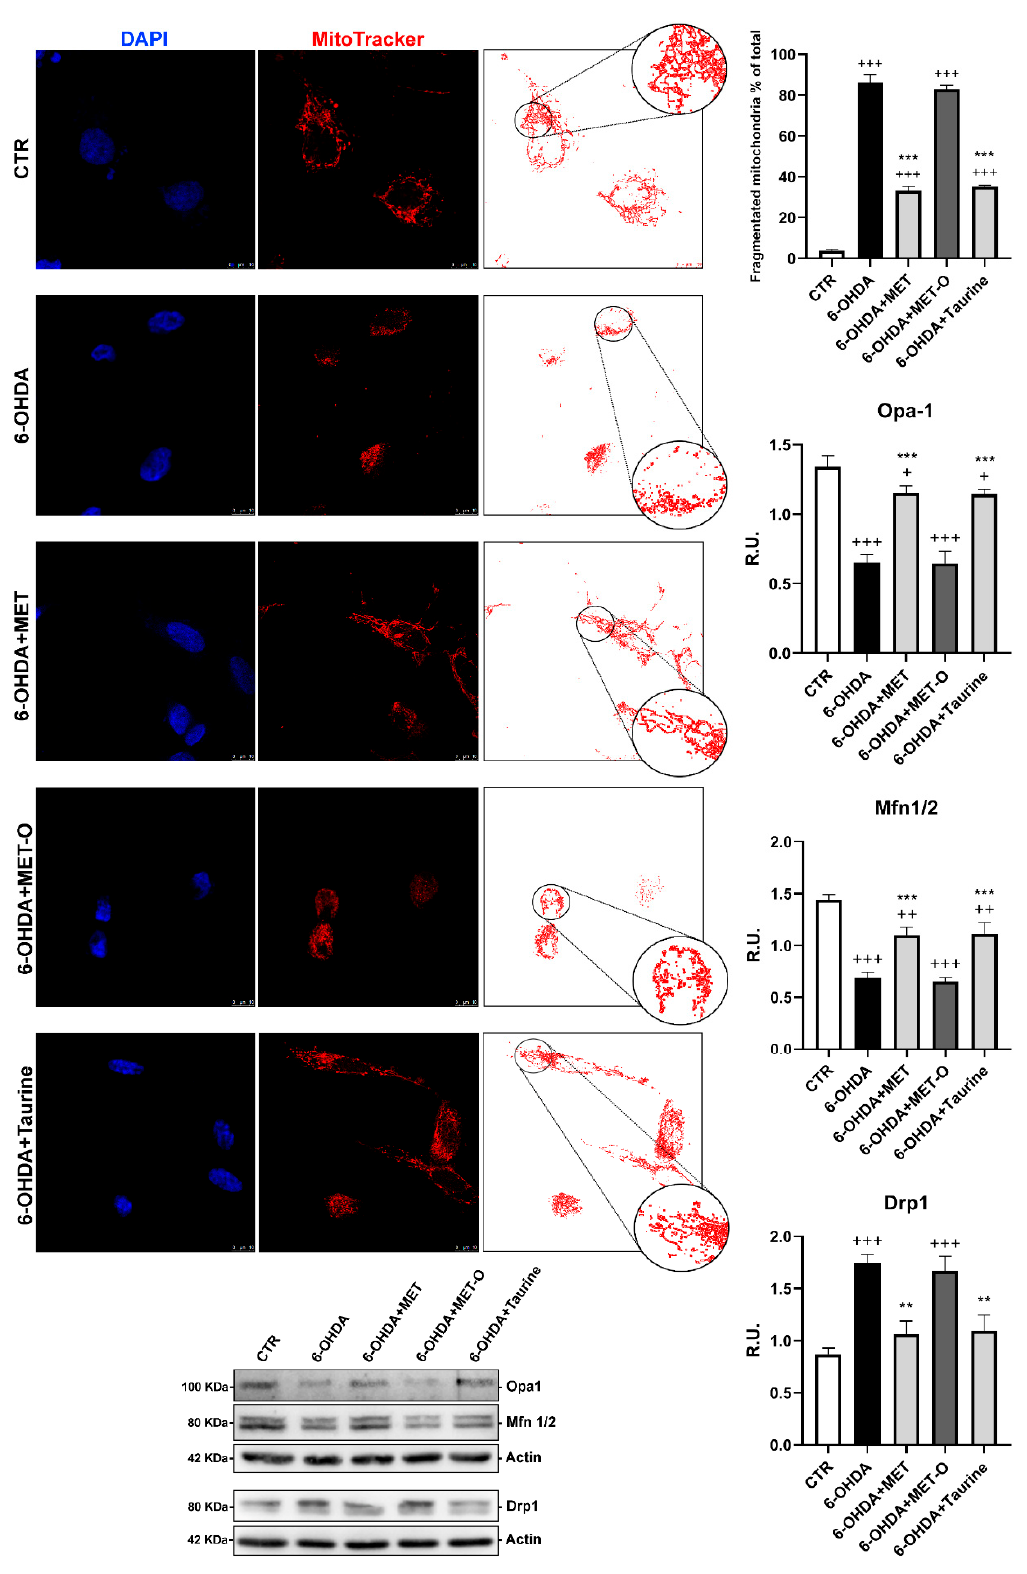
Figure 10. DAPI, Mitotracker deep red, and the masks generated by ImageJ representative images are reported. In the red circle the area is magnified to better appreciate the mitochondrial morphology. WB analyses for fission and fusion pathways. A representative WB figure is shown. Data are mean ± SD of 3 different experiments. *** p < 0.0001, ** p < 0.005 vs. 6-OHDA; +++ p < 0.0001; ++ p < 0.005; + p < 0.05 vs.